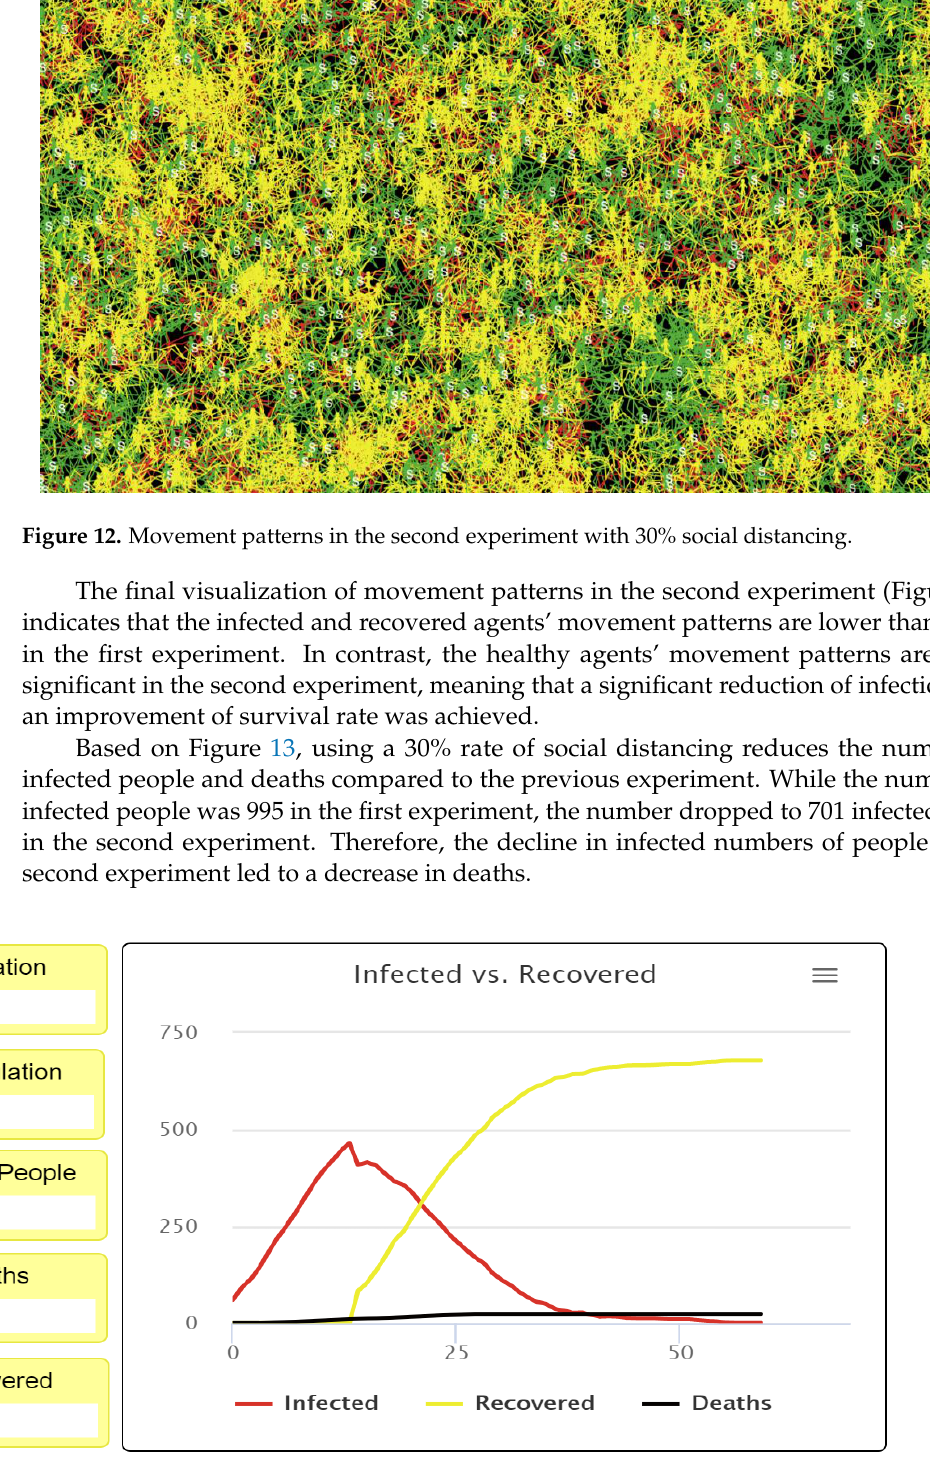
Figure 11. Infected versus the recovered people curve, when the fatality rate is 3% with 0% social distancing.